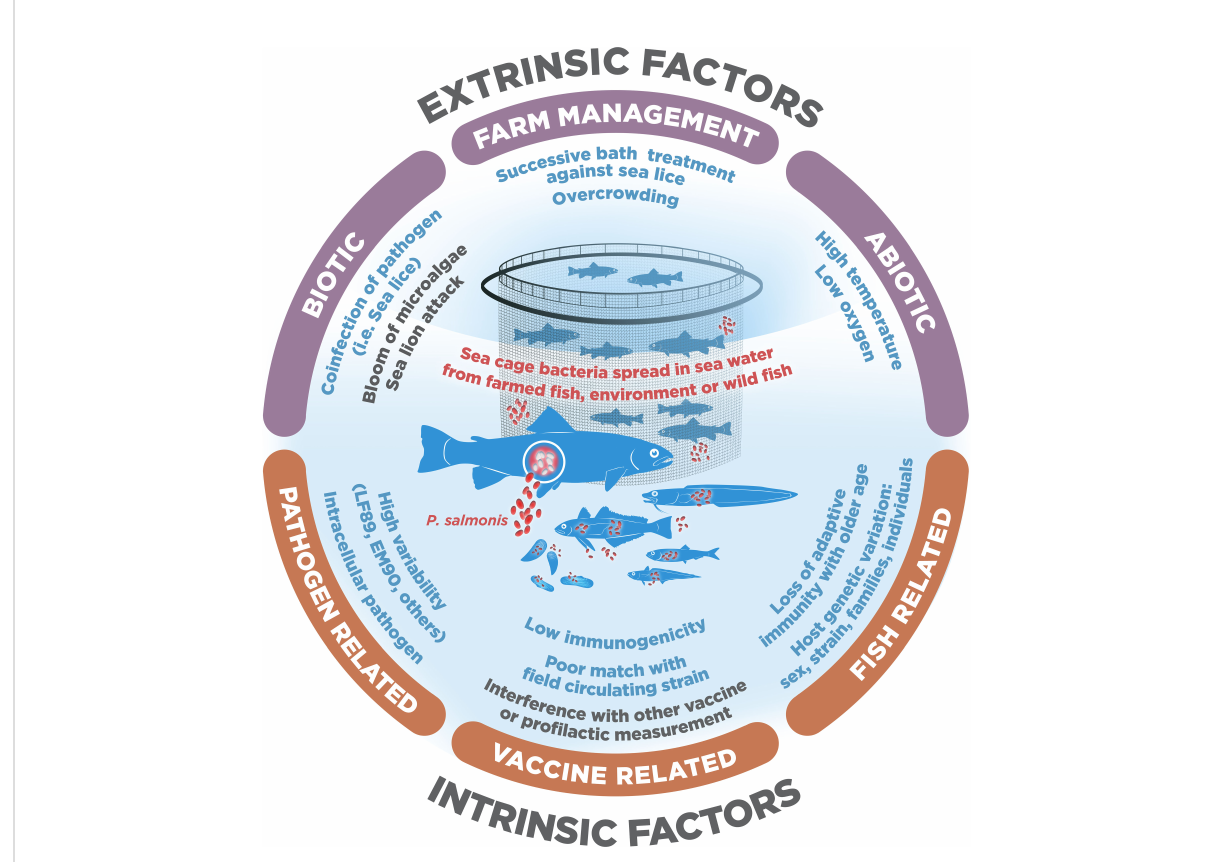
FIGURE 1 Extrinsic and intrinsic factors that decrease Piscirickettsia salmonis vaccine ef fi cacy in salmon and trout Chilean